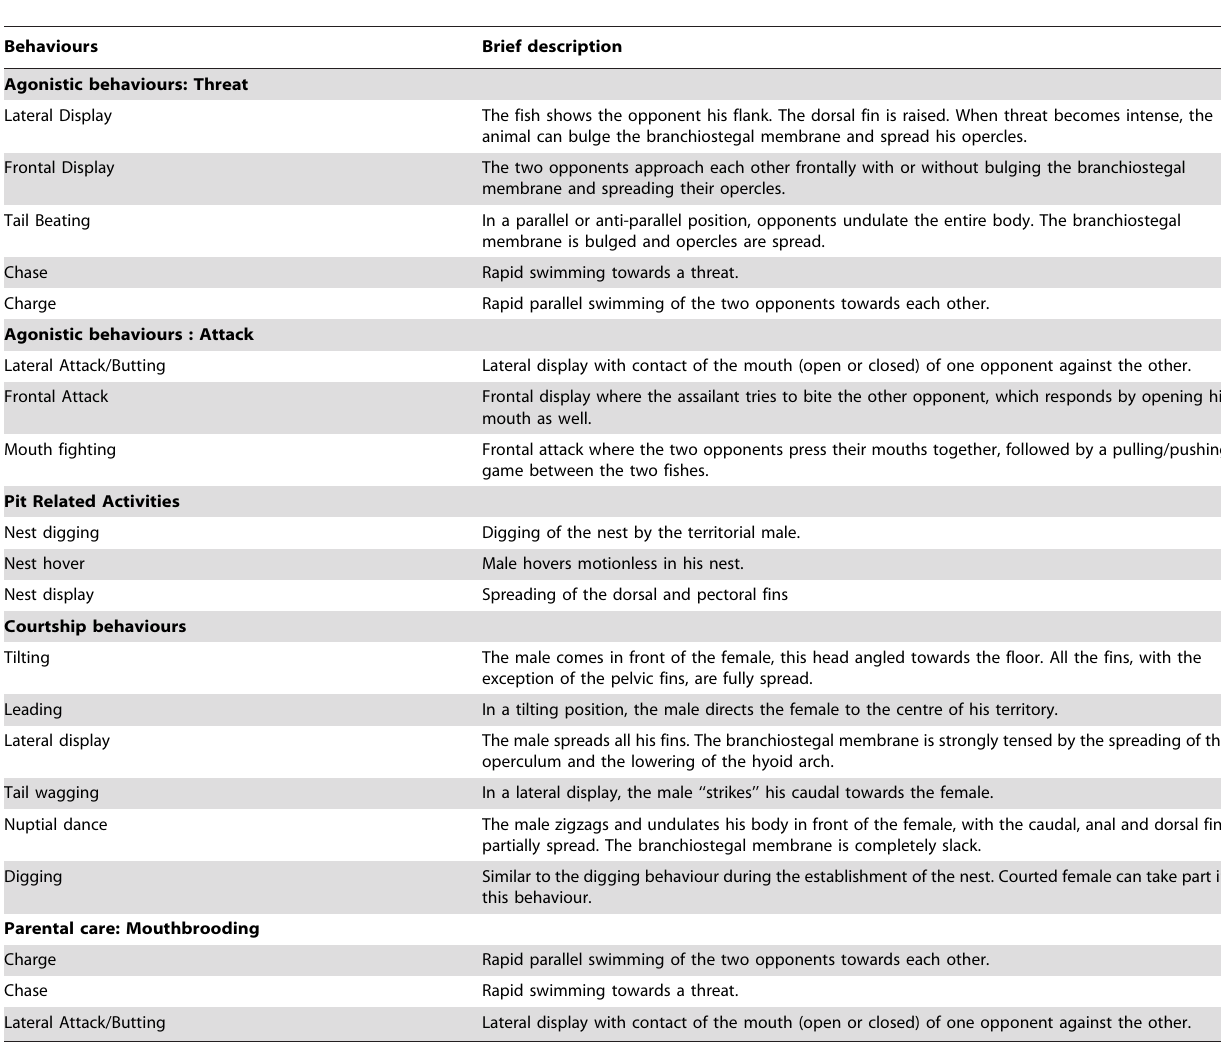
Table 2. Description of Oreochromis niloticus behaviours according to [2,30,34,35,57,73].